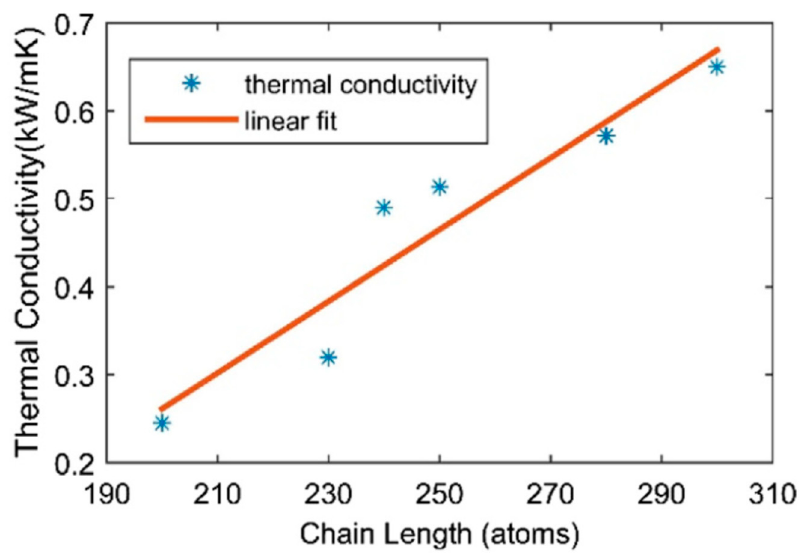
Figure 6. Length dependence effect on thermal conductivity. Reproduced with permission from [10].